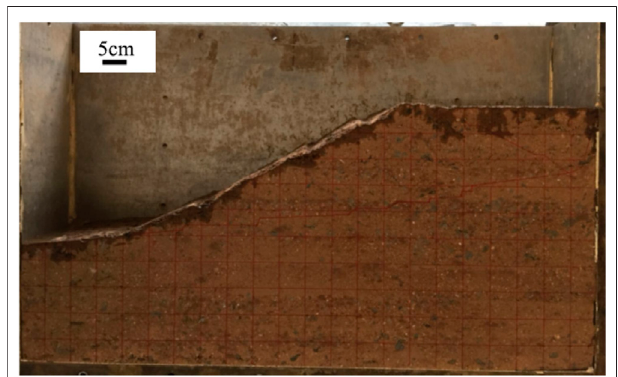
FIGURE 5 | Cutting of the model soil layer.